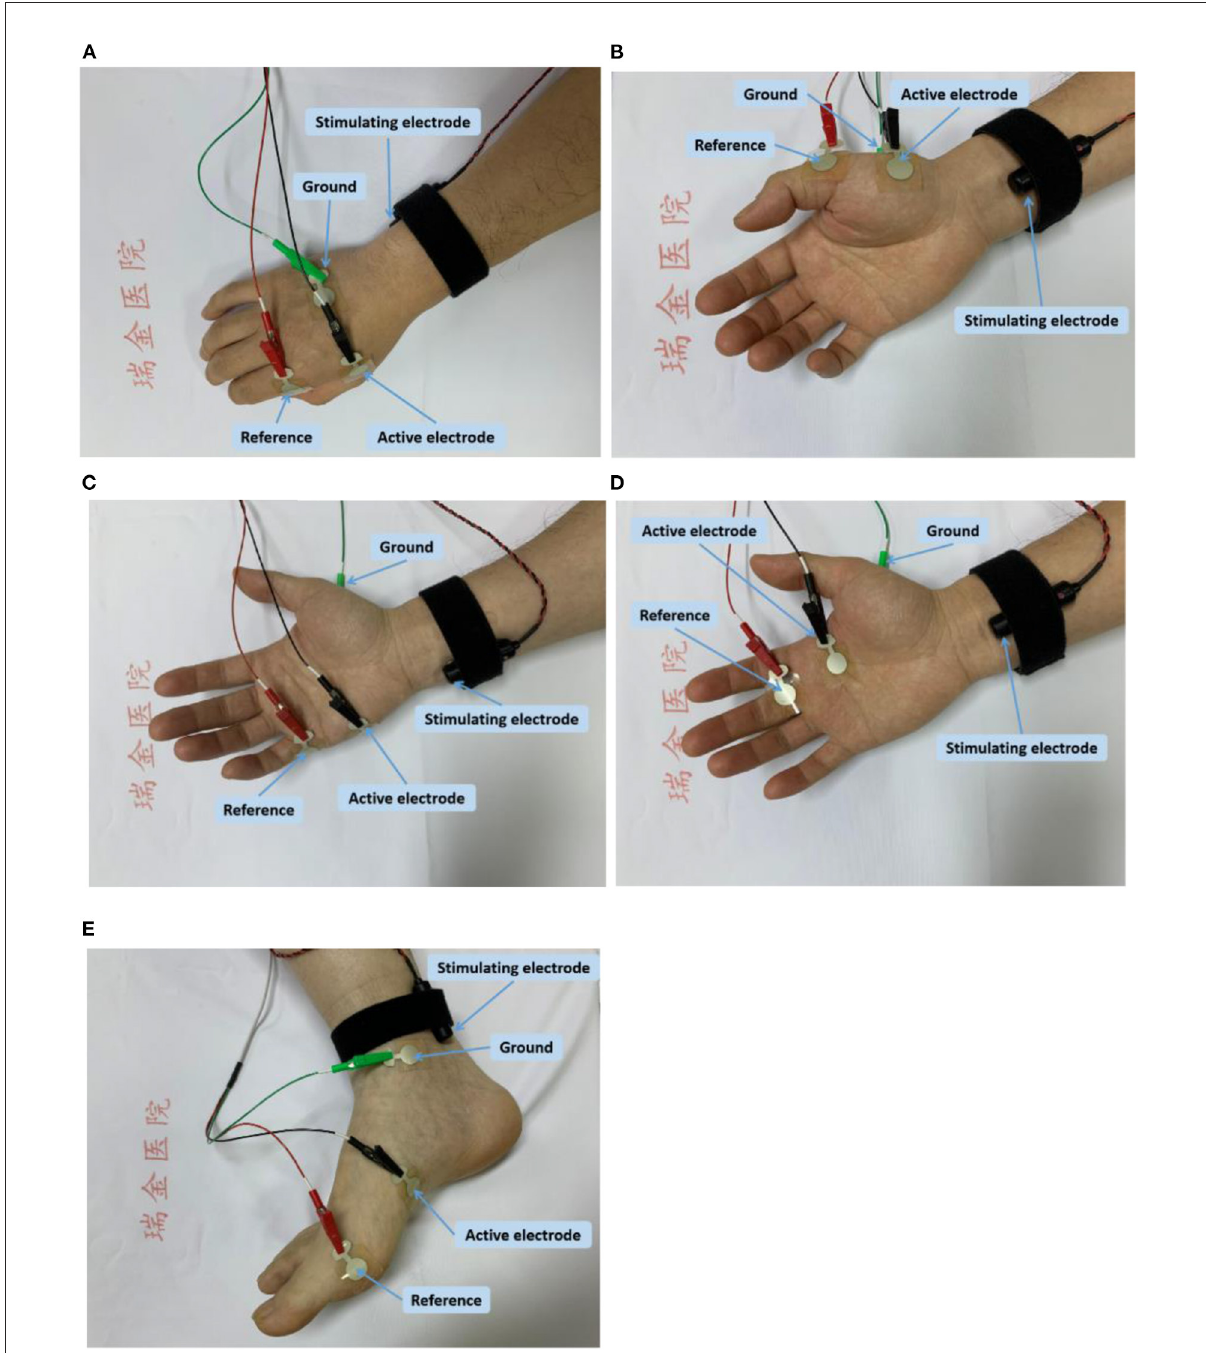
FIGURE1 Electrode placement for CMAP scan of each examined muscle; (A) the FDI muscle; (B) the APB muscle; (C) the ADM muscle; (D) the SL muscle; and (E) the AH